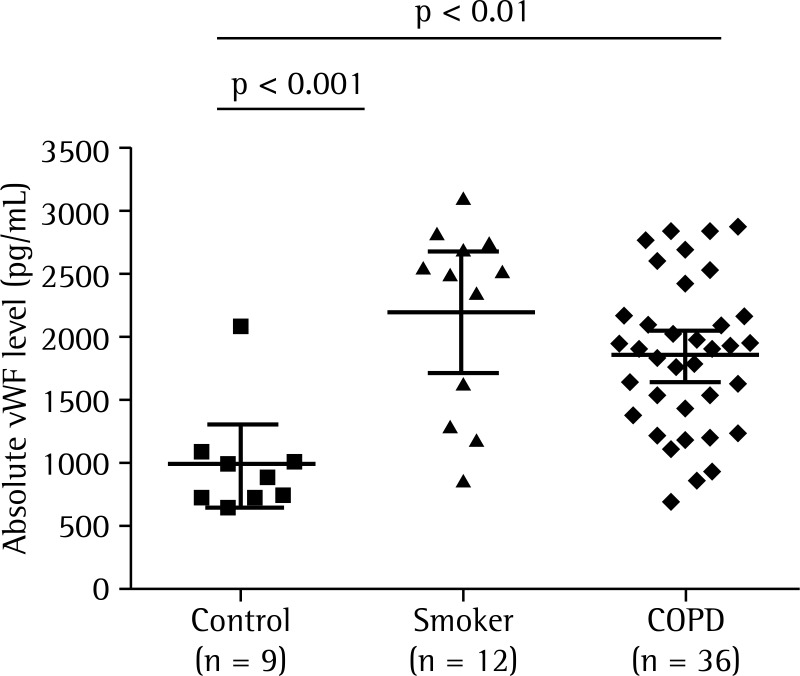
Absolute serum von Willebrand factor (vWF) levels in the groups
studied.